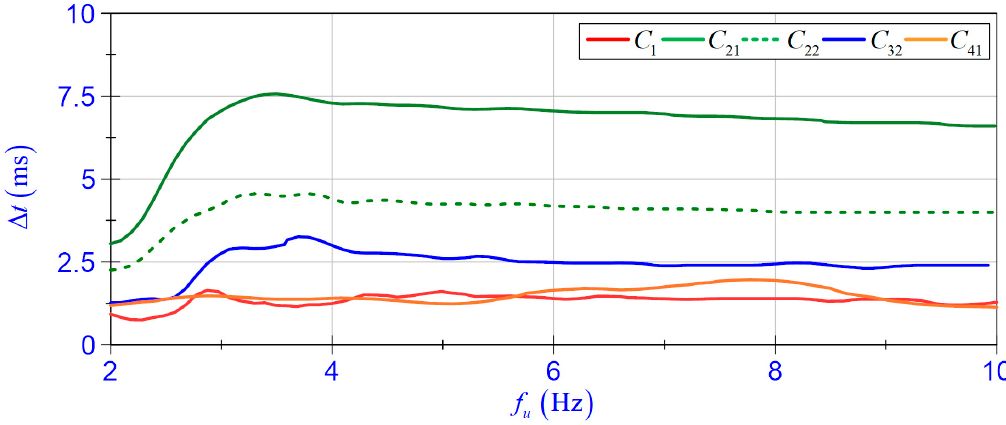
Figure 10. Time shift coefficient ∆𝑡 vs. frequency 𝑓 (cid:3048) .